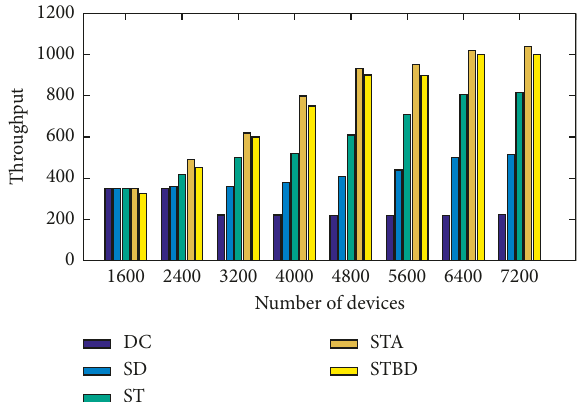
Figure 4: Throughput of the system.